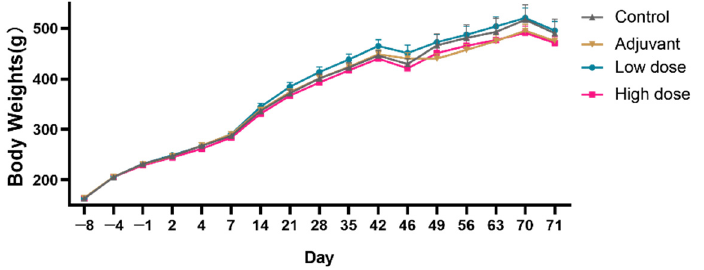
Figure 1. Time course of body weights. Values are the average ± SEM of animals in each group. Levene’s test p ≥ 0.05. All animals were weighed after receiving vaccines and before grouping (D − 4); the animals in groups 1 − 4 were weighed at D − 1, D2, D4, and D7, and for the remaining time, they were weighed once a week.